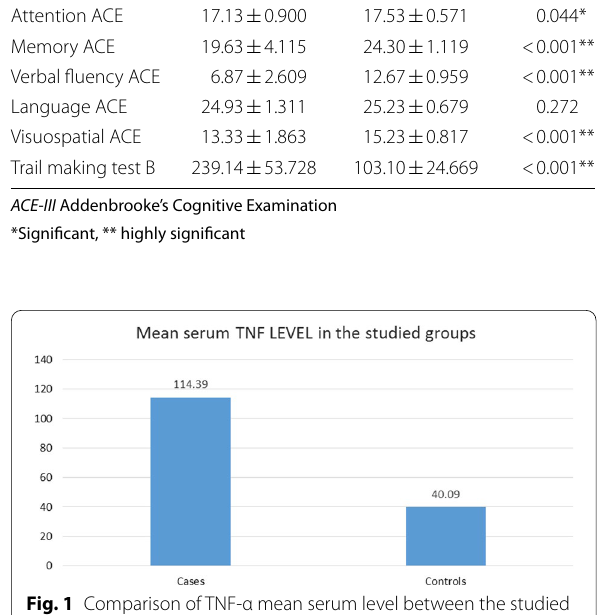
Fig. 1 Comparison of TNF‑α mean serum level between the studied groups. Mean serum TNF level was significantly greater in PD patients